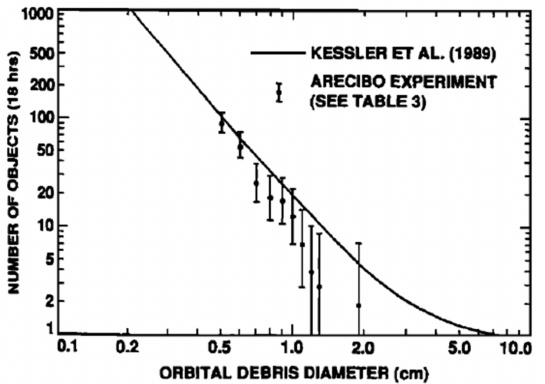
Figure 14. Results of the 1989 Arecibo experiment compared with a prediction model for small-sized debris [30]. Reprinted from Geophysical Research Letters, Copyright 1992, with permission from John Wiley and Sons.